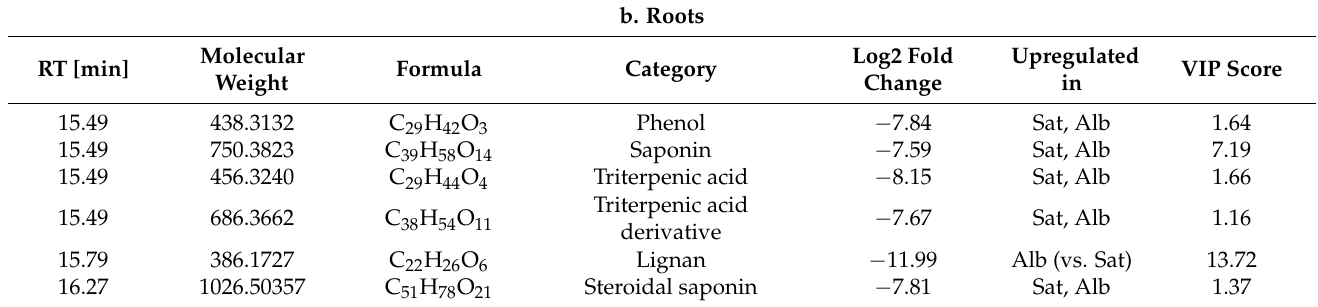
Table 2. Cont. b. Roots